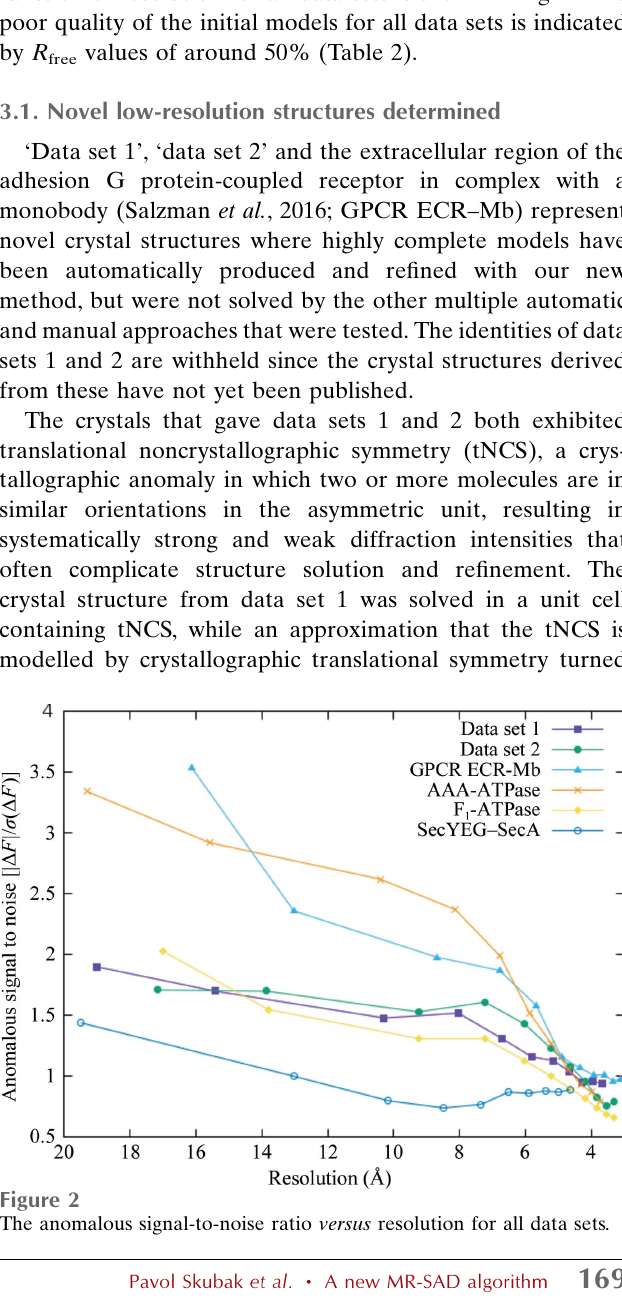
Table 2 R free values for models after molecular replacement and after the automated CRANK 2 pipelines.